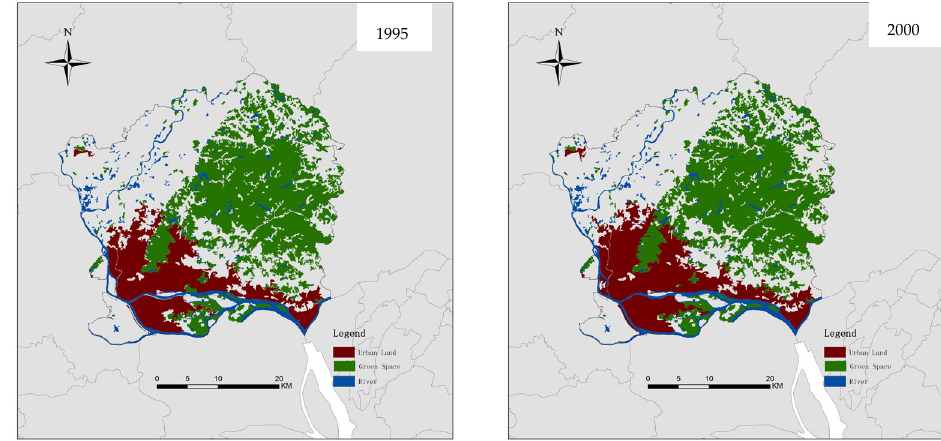
Figure 10. Urban expansion from 1995 to 2000. (Source: drawn by the authors).